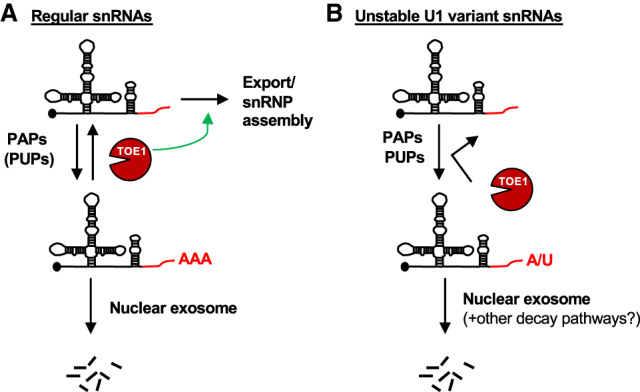
TOE1 selectively rescues regular snRNAs from nuclear decay and promotes their maturation. (A) TOE1 opposes adenylation and processes 3′ tails of regular snRNAs, thus rescuing them from decay by the nuclear exosome and promoting their progression through snRNA biogenesis. (B) Variant U1 snRNAs are poorly processed by TOE1 and instead are substrates for degradation.